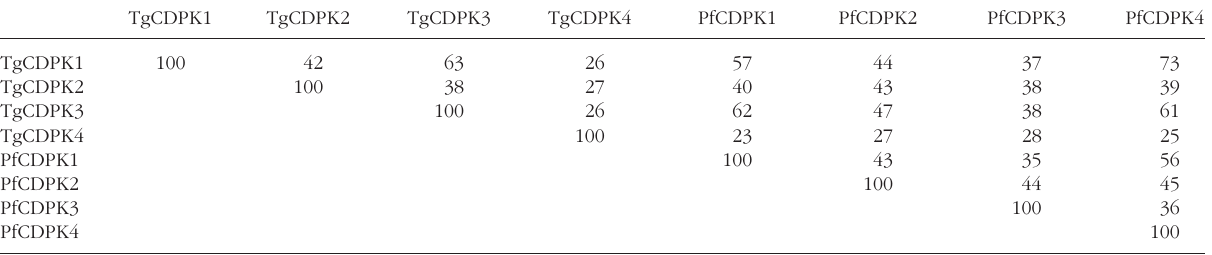
Table I. – A multiple sequence alignment was obtained by pair-wise (%